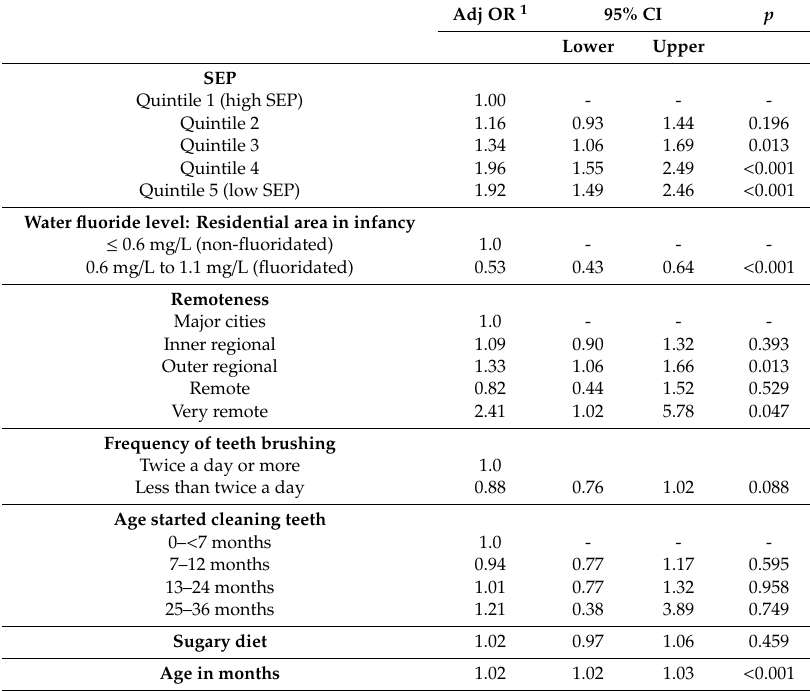
Table 2. Findings of multilevel mixed-e ff ects logistic regression: Association with caries experience.